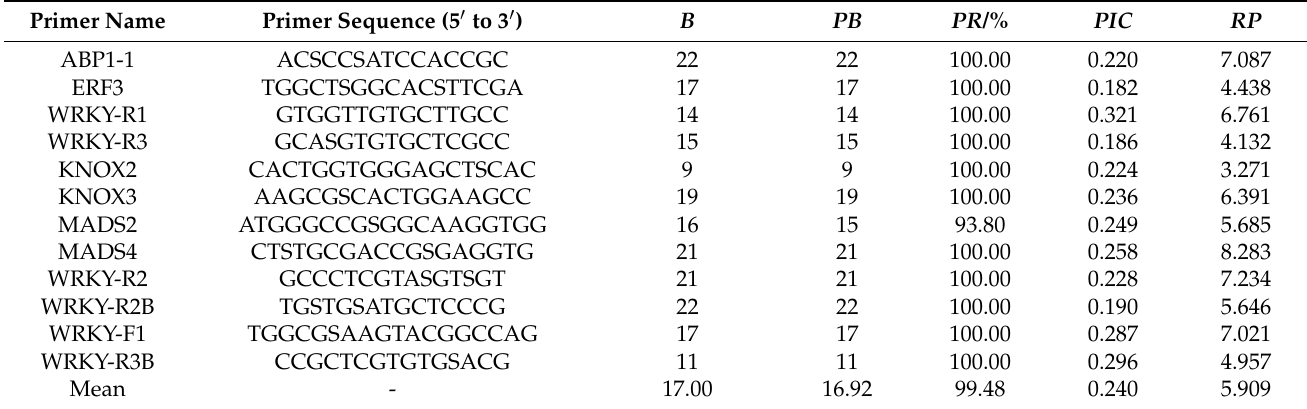
Table 3. Sequences and amplification results for CDDP